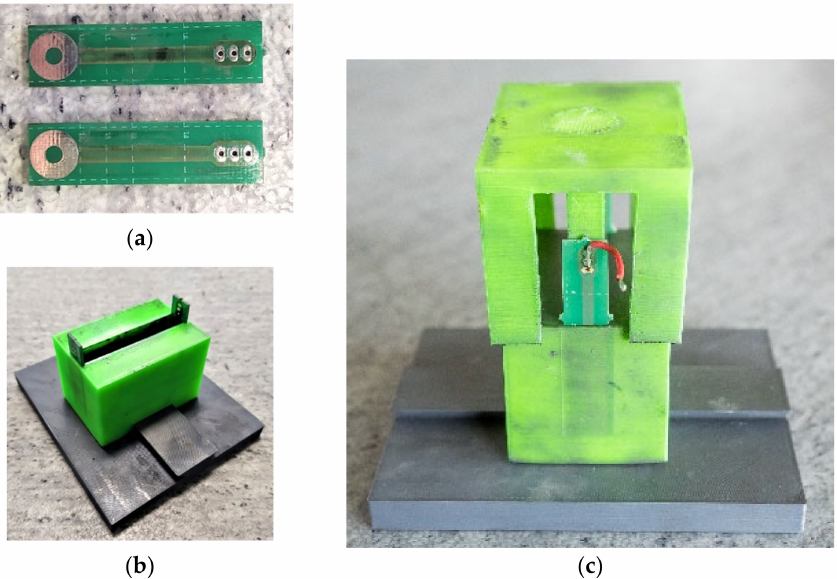
Figure 5. ( a ) A detailed photograph of the electrodes; ( b ) detail of the chamber with inserted electrodes; ( c ) device prepared to achieve the compression pressure, including its upper pared and subsequent measuring of impedance.